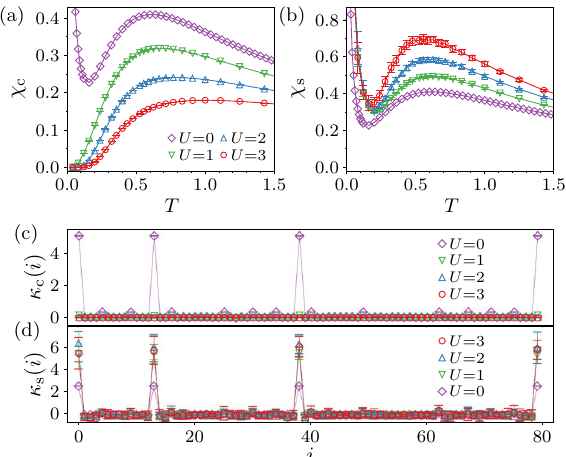
Figure 3. Temperature dependence of ( a ) charge compressibility χ c and ( b ) spin susceptibility χ s at φ = 0.08 for L = 5 under the OBC. Site-resolved ( c ) charge compressibility κ c ( i ) and ( d ) spin susceptibility κ s ( i ) for the system of L = 4 under the OBC at φ = 0.08 and T = 0.08